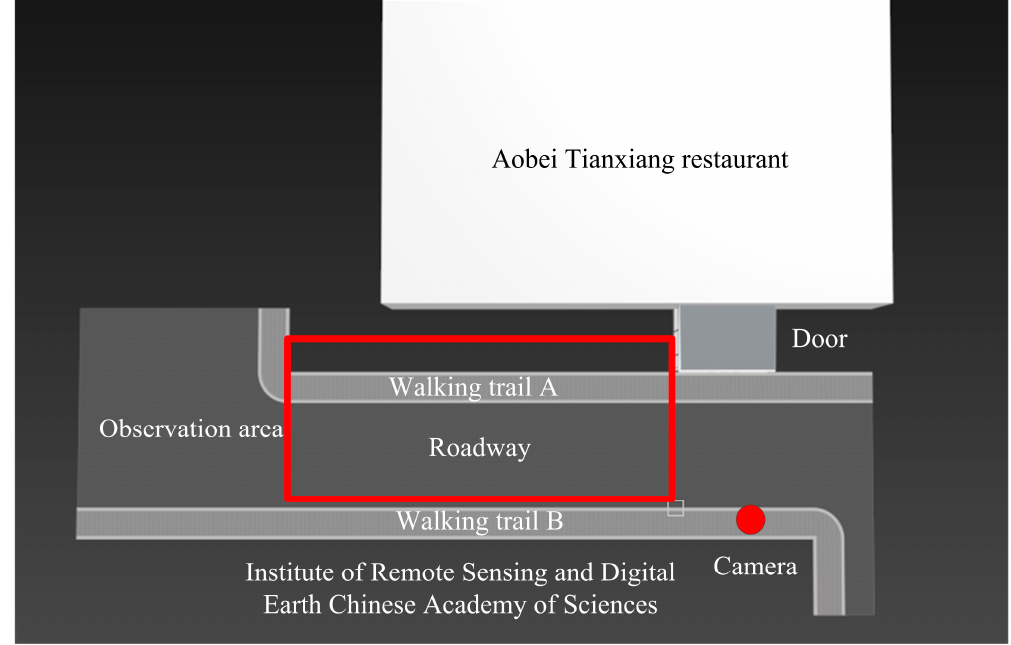
Figure 3. Video data recording area. The red dot denotes the camera position, and the majority of the recorded crowd dynamics are represented by the red box.